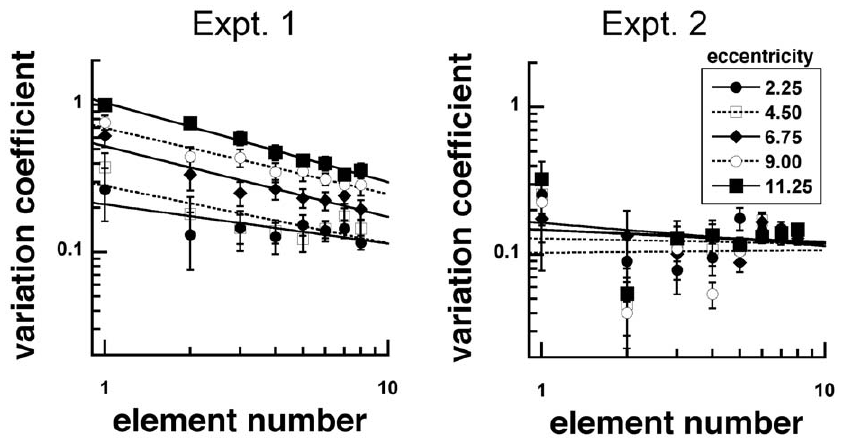
Figure 7. Mean variation coefficients (standard deviation/response) as a function of element number for stimuli with unscaled (Experiment 1) and scaled (Experiment 2) sizes. Variation coefficients increased as viewing eccentricity increased in Experiment 1, but not in Experiment 2.